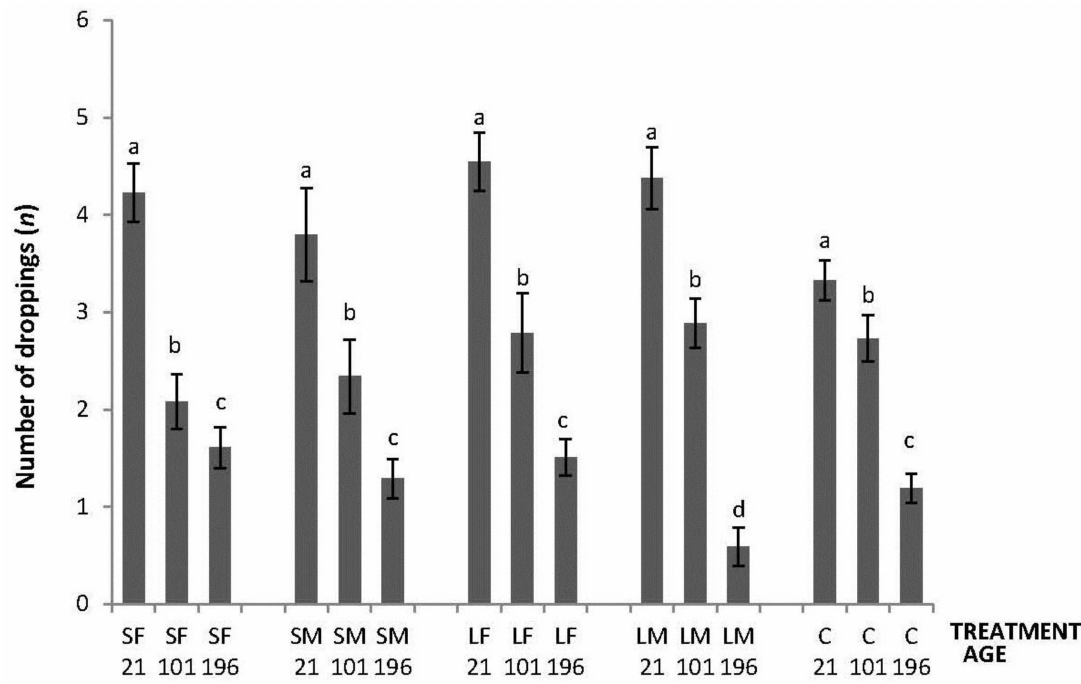
Figure 4. Number of droppings made in 600 s during an OF test by 21, 101, and 196 days old layers from the control and four brooder treatments. Bars with no common letters differ significantly (mixed model ANOVA: p < 0.05). Treatments = SF: small fixed brooder; SM: small movable brooder; LF: large fixed brooder; LM: Large movable brooder; C: